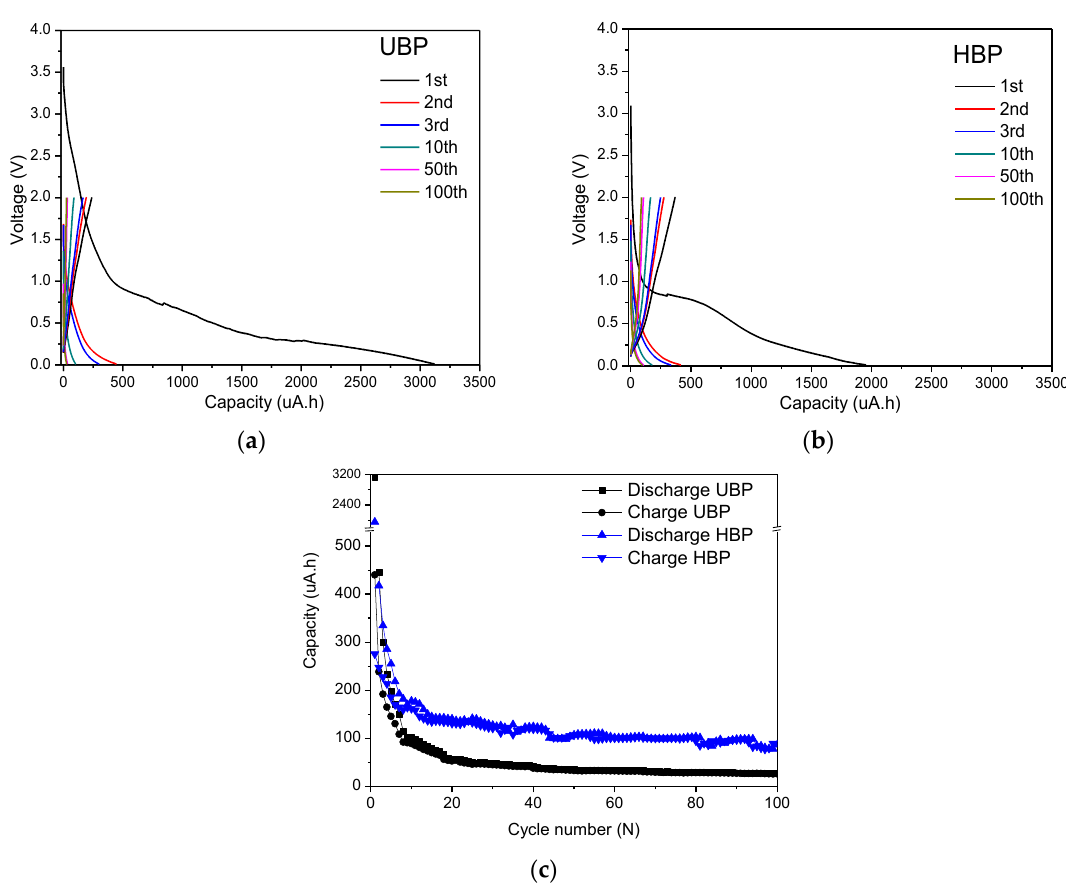
Figure 8. Charge/discharge capacity profile of ( a ) UBP and ( b ) HBP; discharge and charge cycling performance of ( c ) buckypaper electrodes with a current density of 125 μA and cutoff voltage of 0.01–2.0 V.